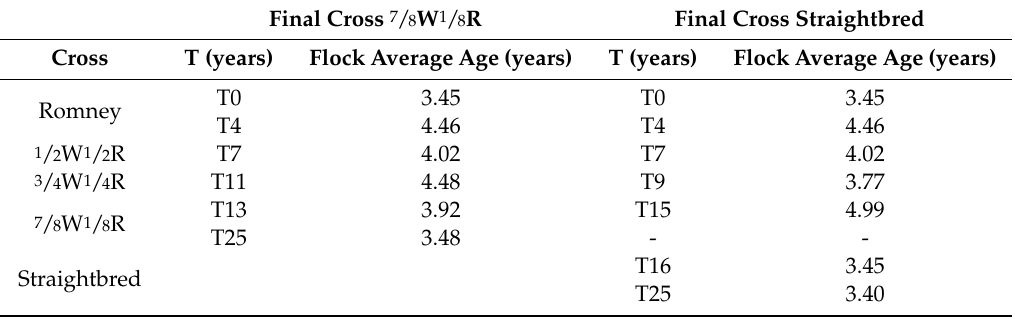
Table 5. Average age of ewes in flock of di ff erent crosses at various time points (T) from the start of a grading up transition from Romney to a desired final cross of either 7 / 8 W 1 / 8 R or